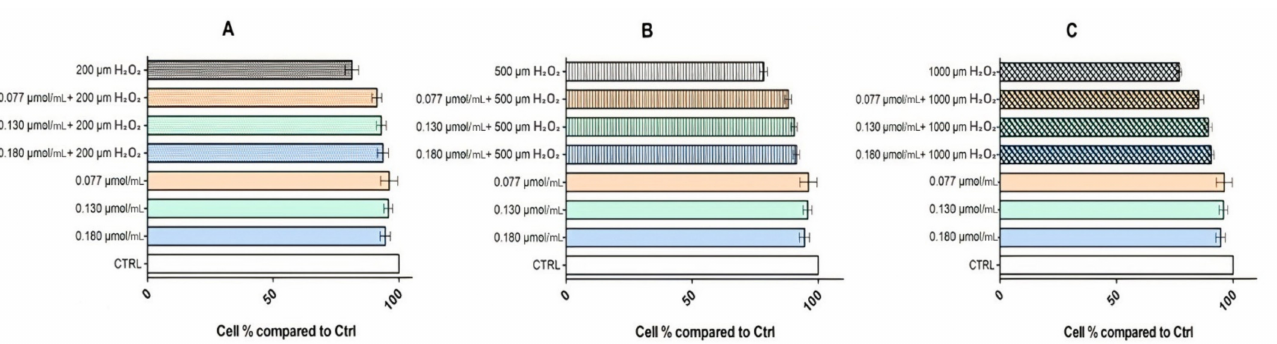
Figure 9. Effects of rhodoxanthin pretreatment on H 2 O 2 -induced B16F10 cells damage. Cell viability detected by MTT assay. B16F10 cells exposed to H 2 O 2 for 2 h. Significance: p < 0.0001 vs. control. B16F10 cells exposed to C1–C3 of rhodoxanthin for 24 h. Significance: p < 0.0010. ( A ) B16F10 cells exposed to C1–C3 and 200 µ m H 2 O 2 . Significance: p < 0.05. ( B ) B16f10 cells exposed to C1–C3 and 500 µ m H 2 O 2 . Significance: p < 0.05. ( C ) B16F10 cells exposed to C1–C3 and 1000 µ m H 2 O 2 . Significance: p < 0.005.